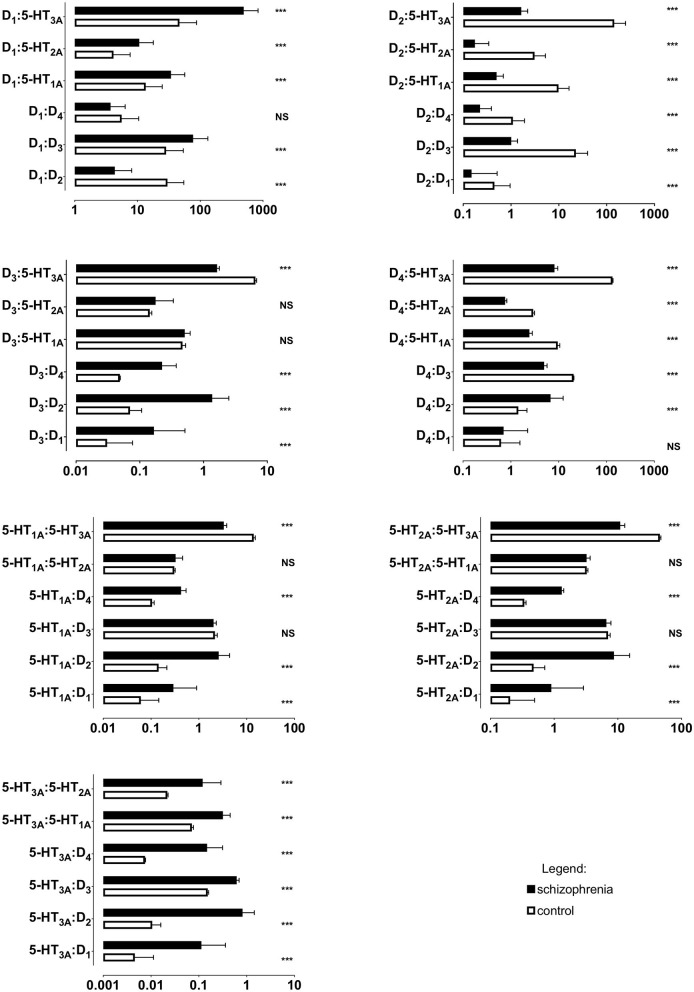
Ratios of mRNA expression of dopamine D1−4 and serotonin 5-HT1A−3A receptors in PBMCs of study subjects (unadjusted for smoking). Horizontal bar represent mean and standard deviation. *** p < 0.001; NS, non-significant; X axes are log10 scaled.